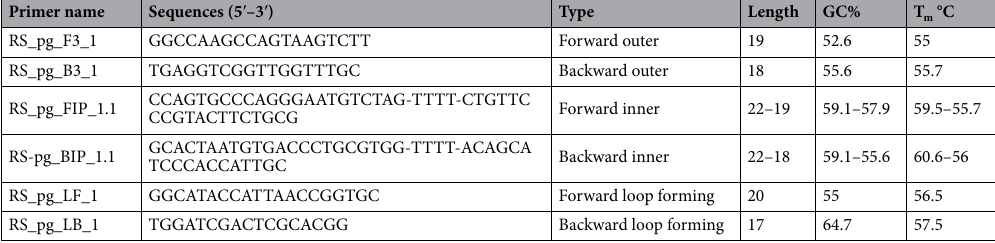
Table 4. Primers designed for LAMP